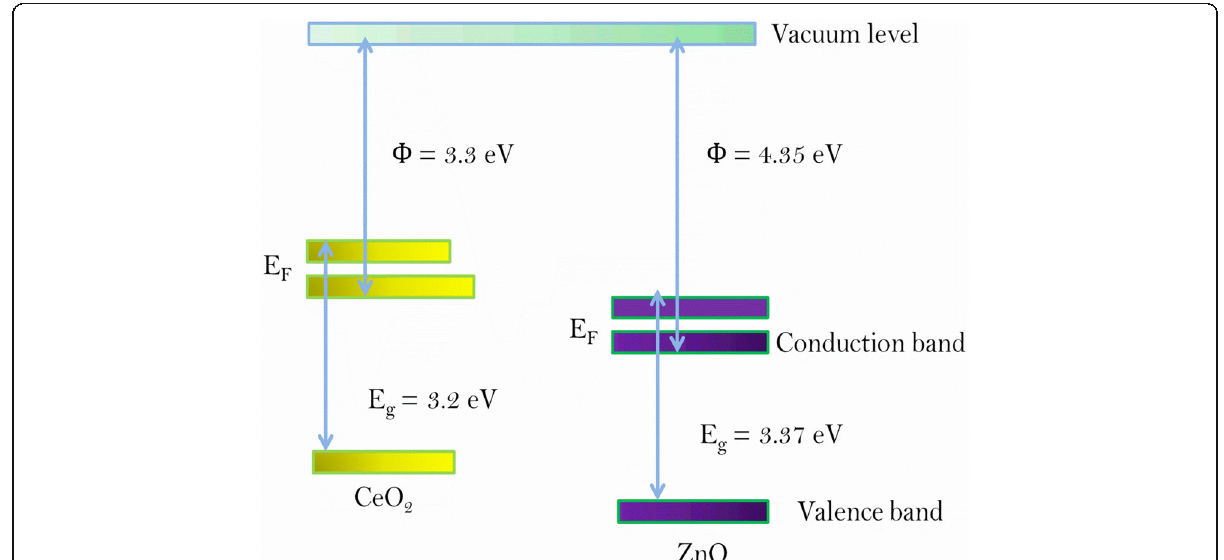
Fig. 7 Energy band diagram of CeO 2 and ZnO n-type semiconducting